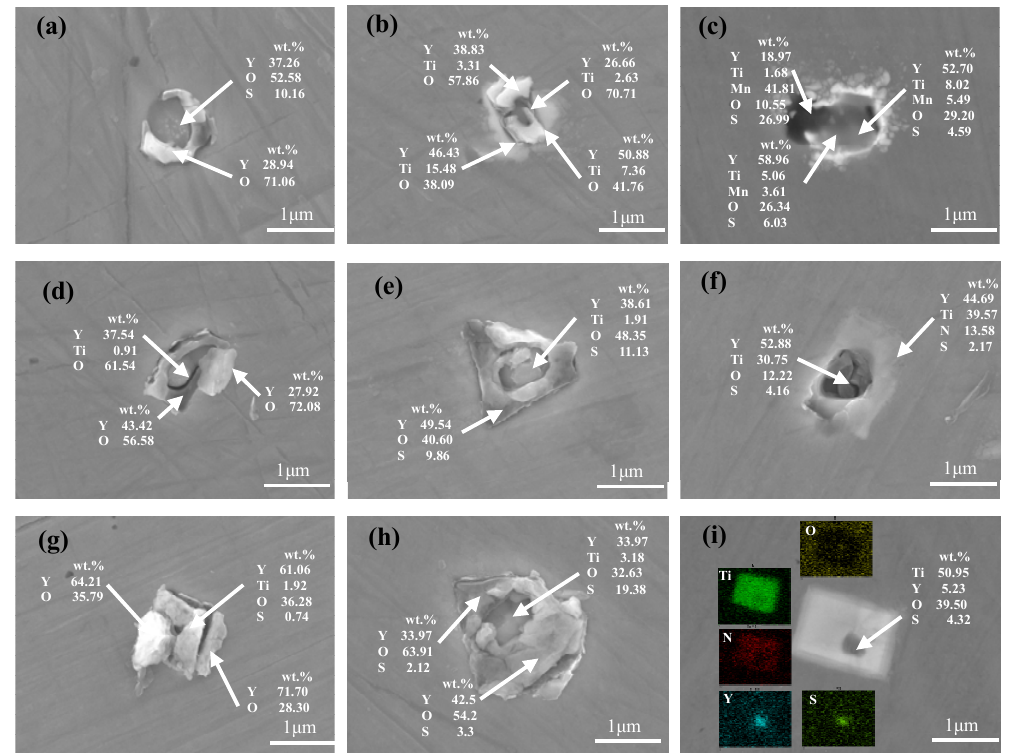
Figure 2. Typical inclusion morphologies in the alloys: ( a ) C1; ( b , c ) C2; ( d–f ) C3; and ( g–i ) C4.